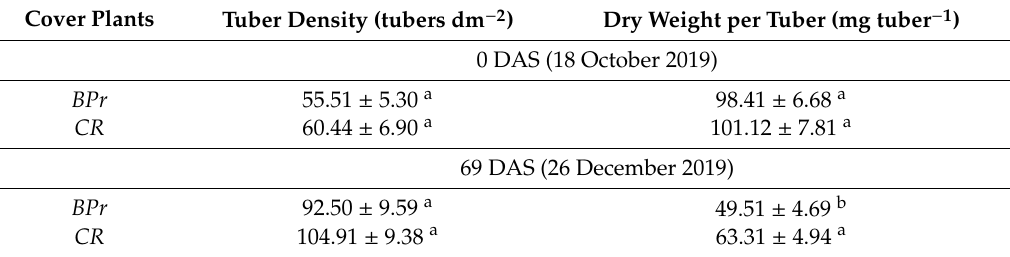
Table 5. In the field severely invaded by CR , the influence of BPr as cover plants on the tuber density and dry weight per tuber of CR . The investigation was conducted on 0 and 69 days after sowing (DAS). Cover